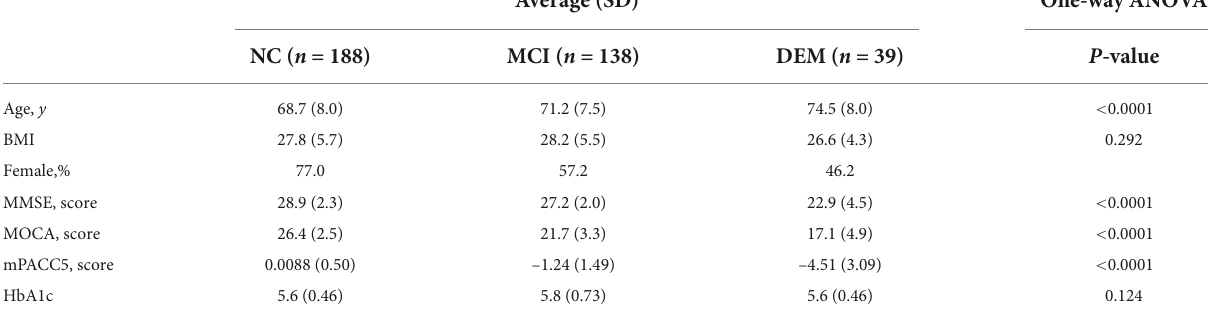
TABLE 2 Demographics and cognitive scores for validation